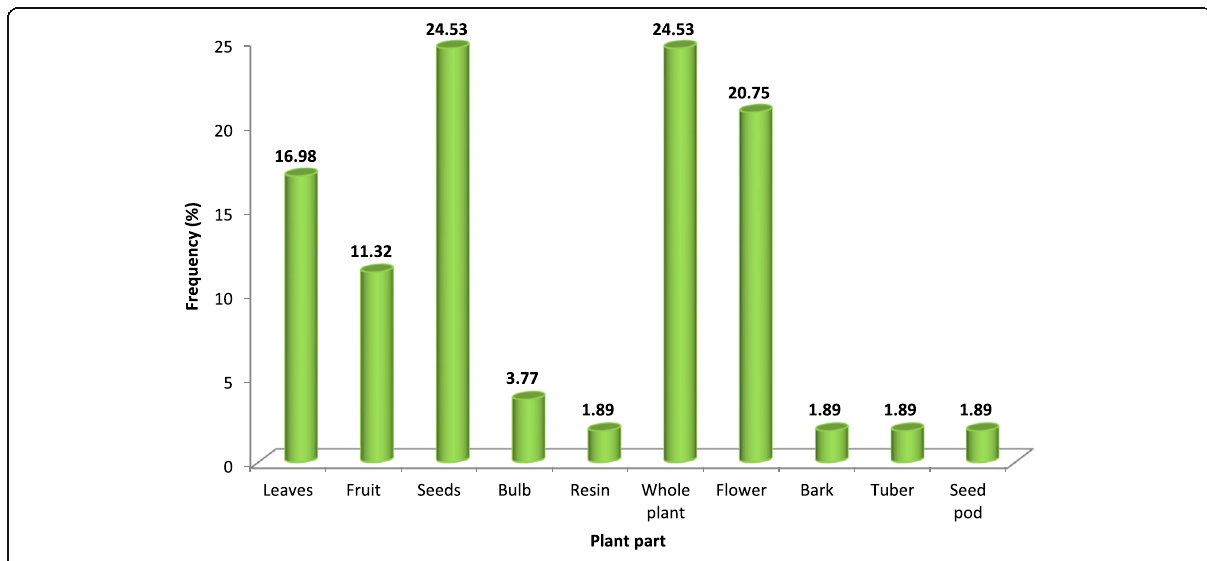
Fig. 3 Percentage use of plant based on the